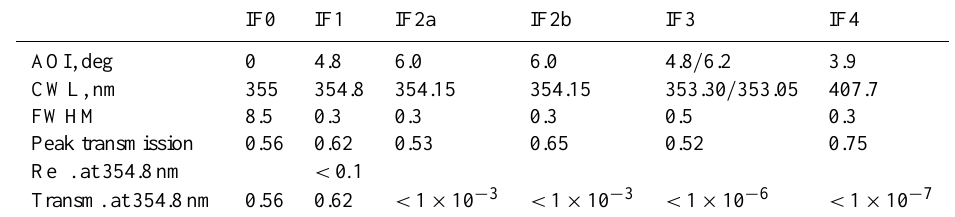
Table 1. Parameter of interference filters. AOI: angle of incidence; CWL: central wavelength; FHWM: full width at half maximum.